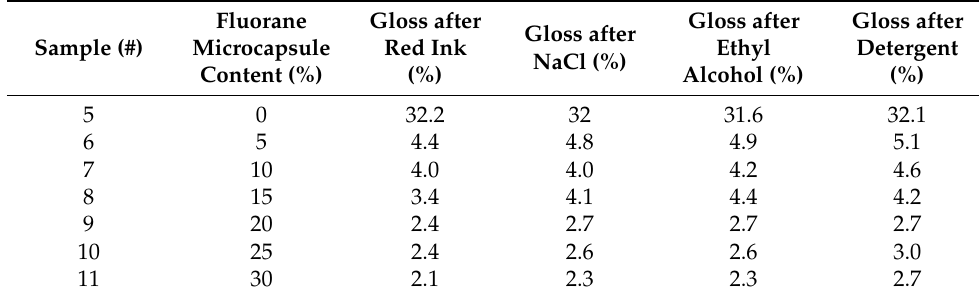
Table 8. The 60 ◦ gloss of the topcoat with fluorane microcapsules after liquid resistance.